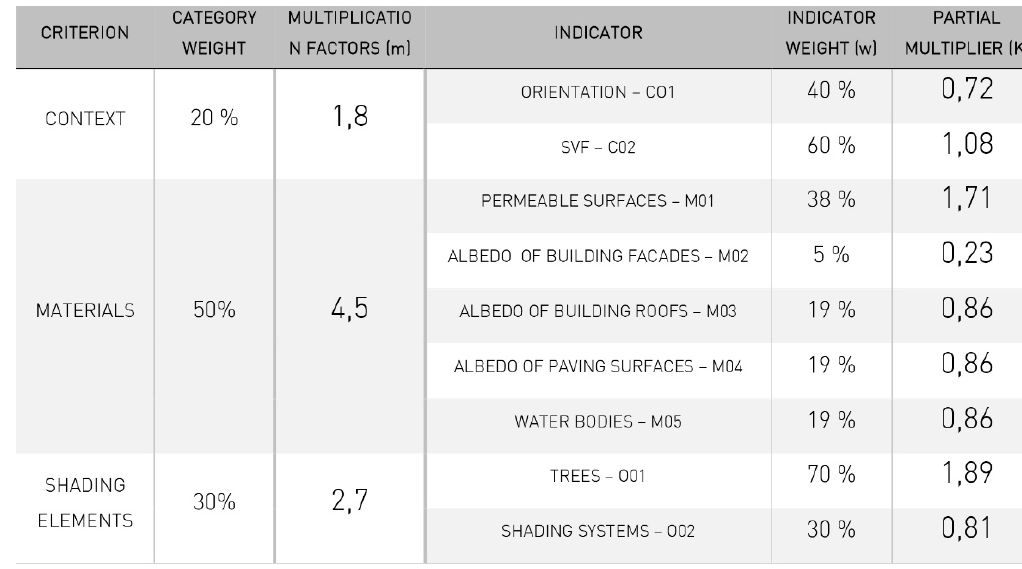
Figure 13. Benchmark of the indicators core set: weights and influence factors of criteria and indi- cators.